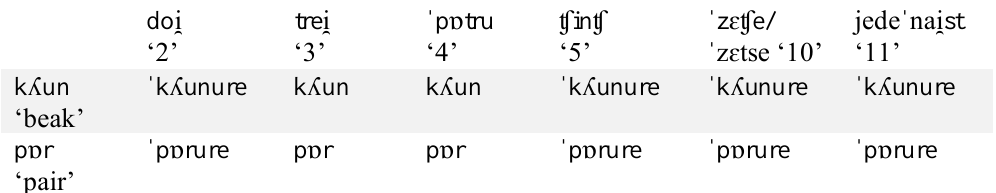
Table 17. Selection of different plural forms for phrases with quantifiers ‘3’ and ‘4’ in responses from PG